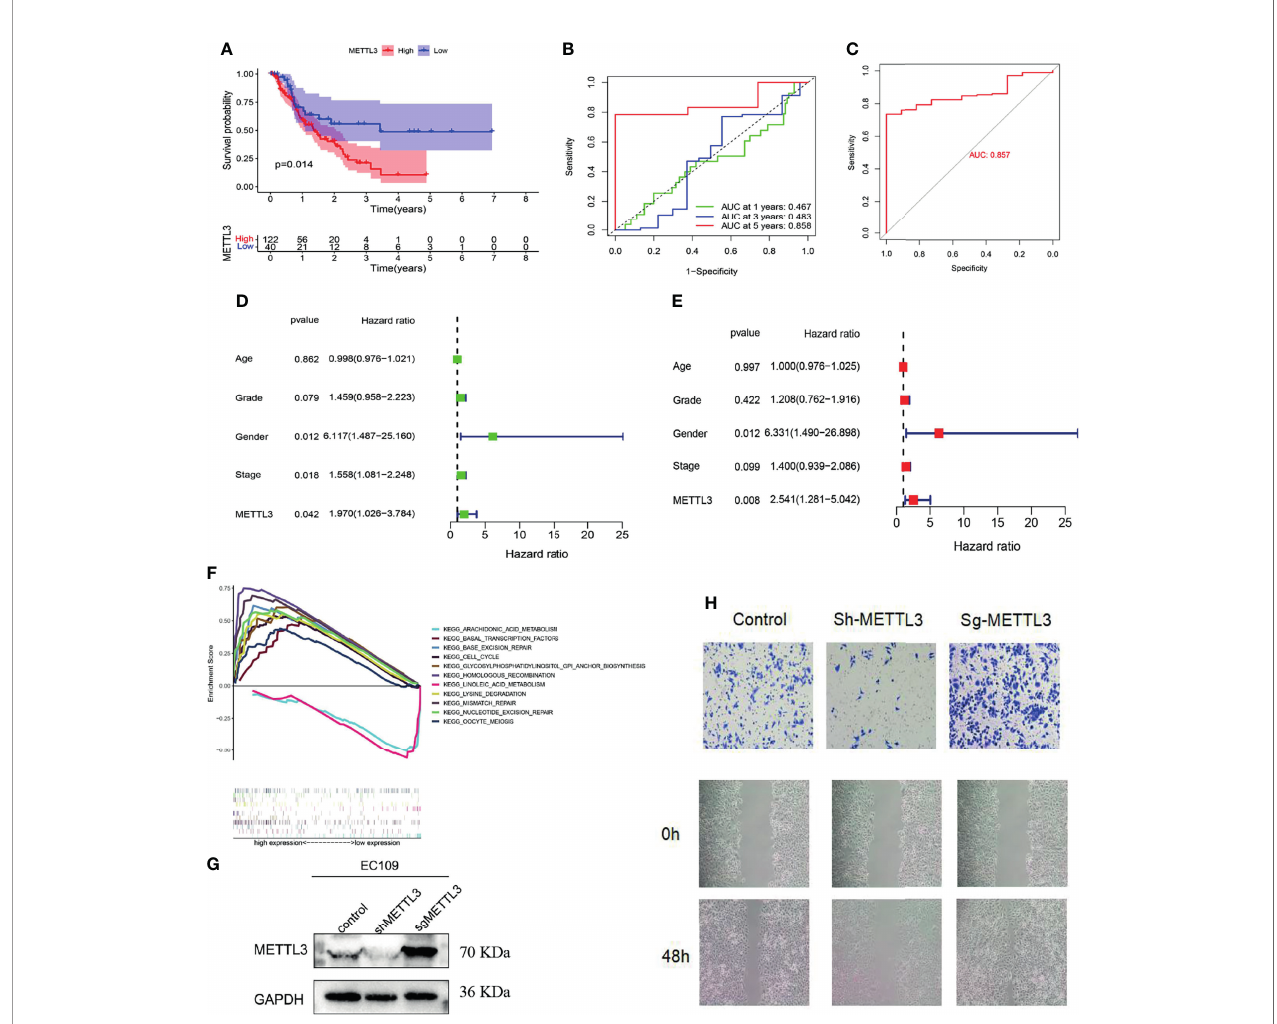
FIGURE 2 | Function and clinical signi fi cance of METTL3 in ESCC. (A) PFS analysis of METTL3 in the high and low expression groups ( P = 0.014). (B, C) ROC curve analysis to evaluate the prognostic performance (AUC = 0.858) and diagnostic performance (AUC = 0.857) of METTL3 in ESCC. (D, E) Cox regression (univariate and multivariate) analysis indicated that METTL3 could be utilized as a prognostic marker for ESCC (using PFS data, P = 0.008, HR = 2.541). (F) Analysis of METTL3 functionality through GSEA. (G, H) METTL3 ’ s migration ability was identi fi ed using wound healing and cell migration